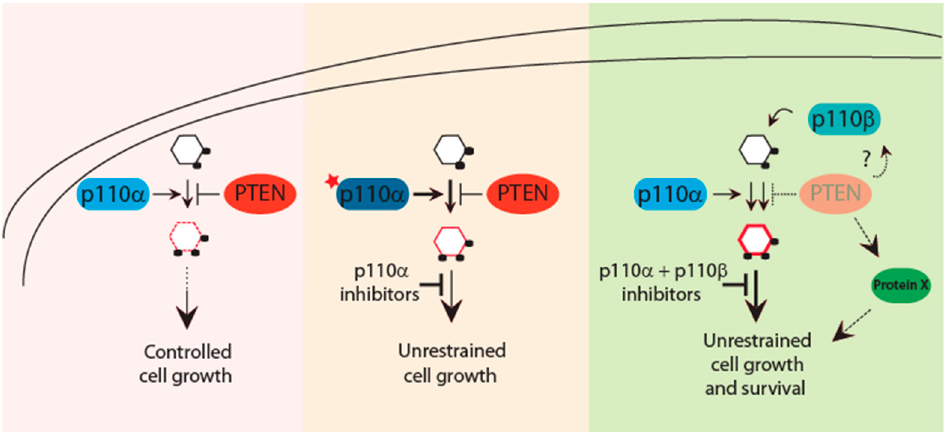
Figure 2. The PTEN-PI3K axis dictates response to PI3K-directed therapies. Finely regulated PIP3 levels are under the control of the PI3K–PTEN axis. Acquisition of PIK3CA mutations tilts the physiologic balance to overcome PTEN inhibition and promote tumorigenesis. PIK3CA mutant cancers are sensitive and better respond to isoform-specific PI3K inhibitors. Loss of PTEN function has been associated with activation of multiple p110 isoforms that act with tissue-specific dependencies. Thus, PTEN-deficient tumors may require inhibition of more than one p110 isoform for effective therapies. Further, multiple PTEN-protein targets have been identified which can contribute to the PTEN-driven tumorigenesis. These substrates together with PI3K inhibitors can provide a better therapeutic option for PTEN mutant cancers.